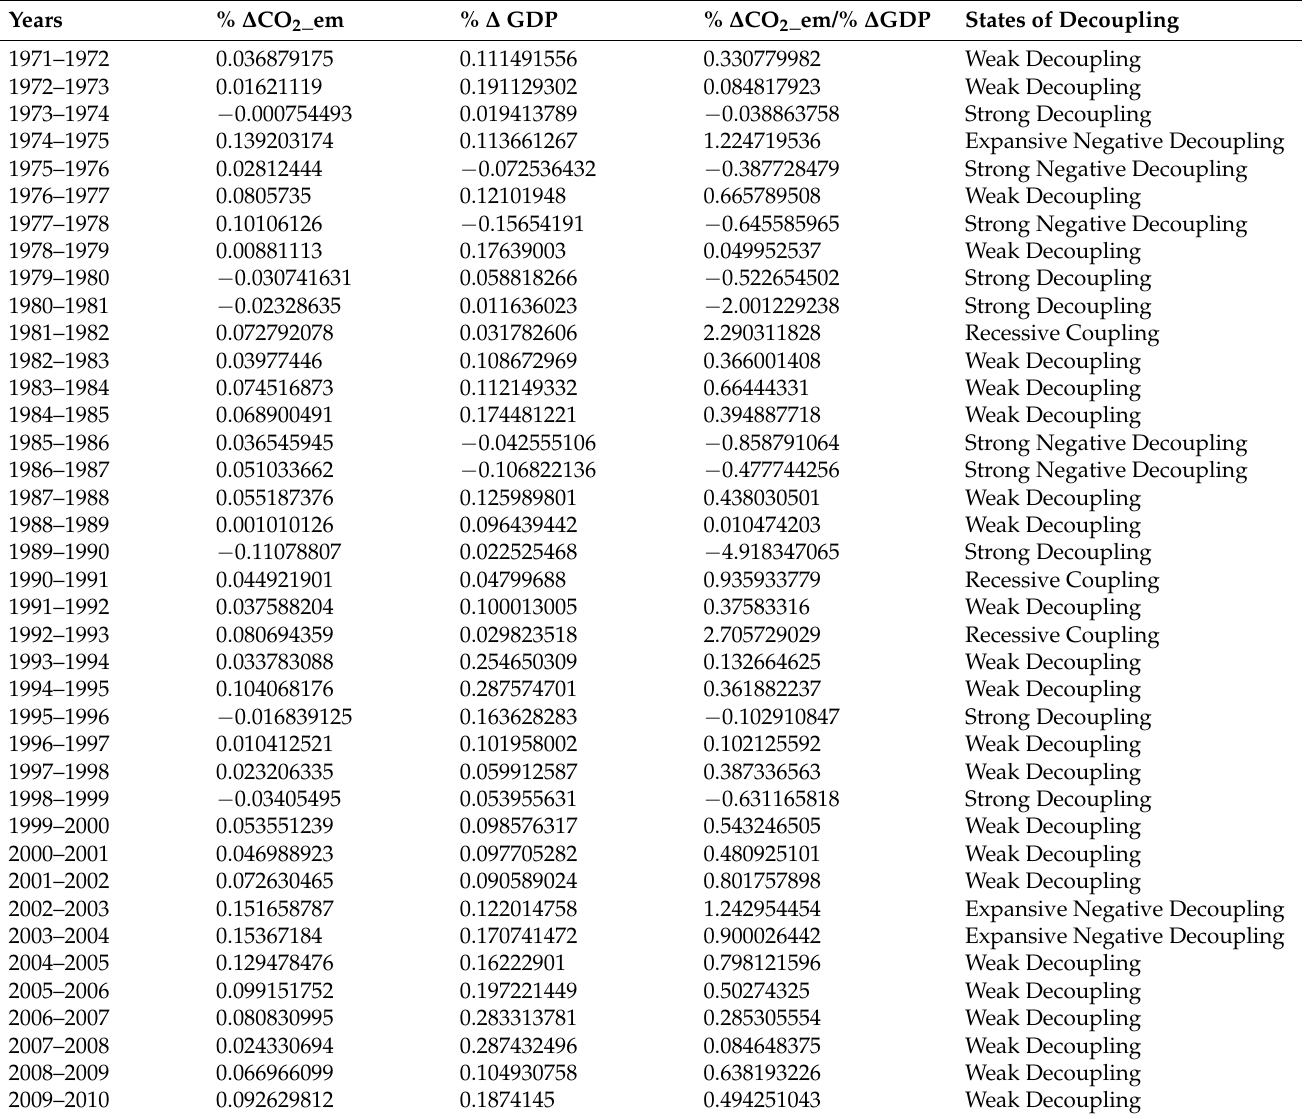
Table 6. The states of decoupling of CO 2 emissions and GDP in China during